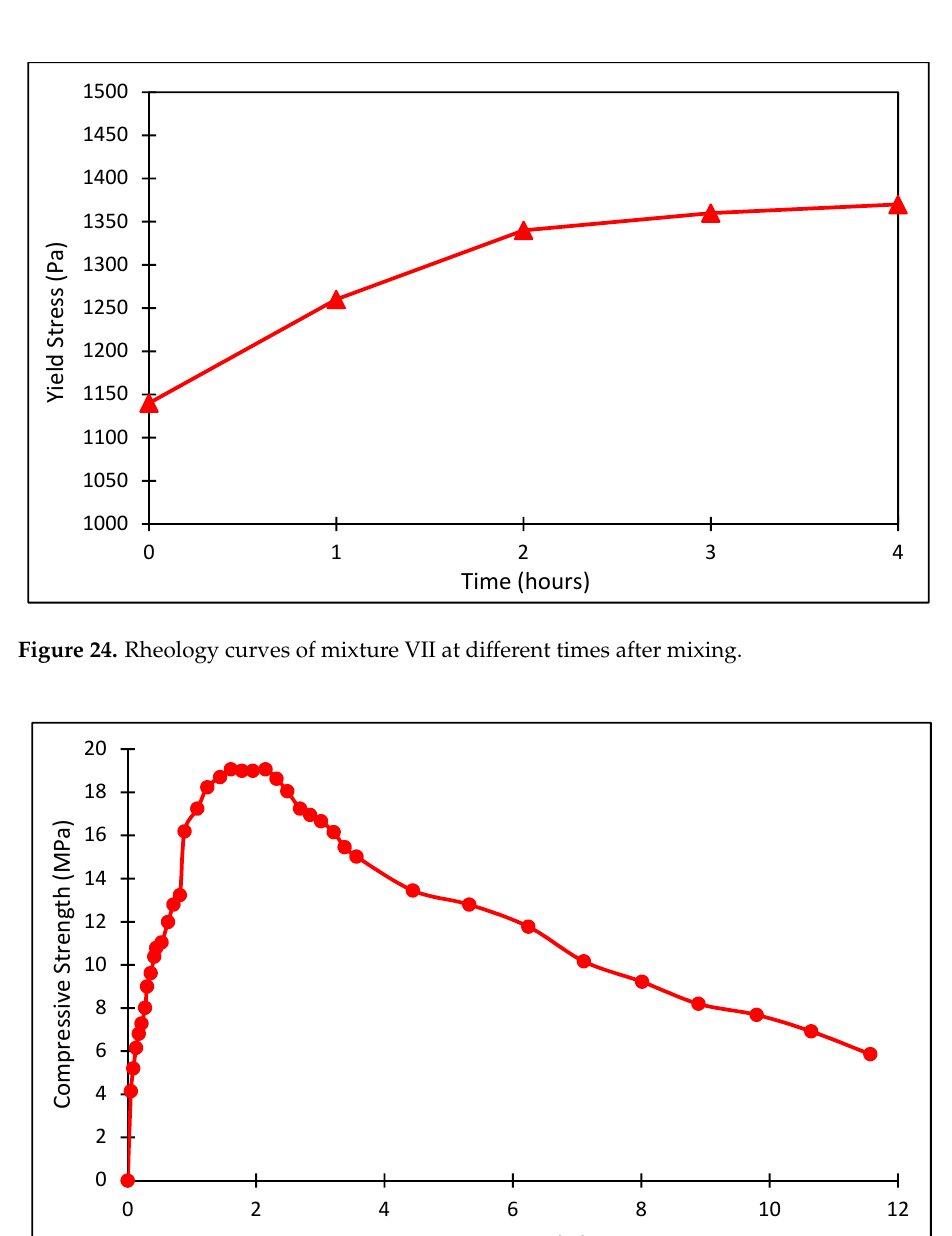
Figure 25. Stress–strain graph for the geopolymer created using Method VII.